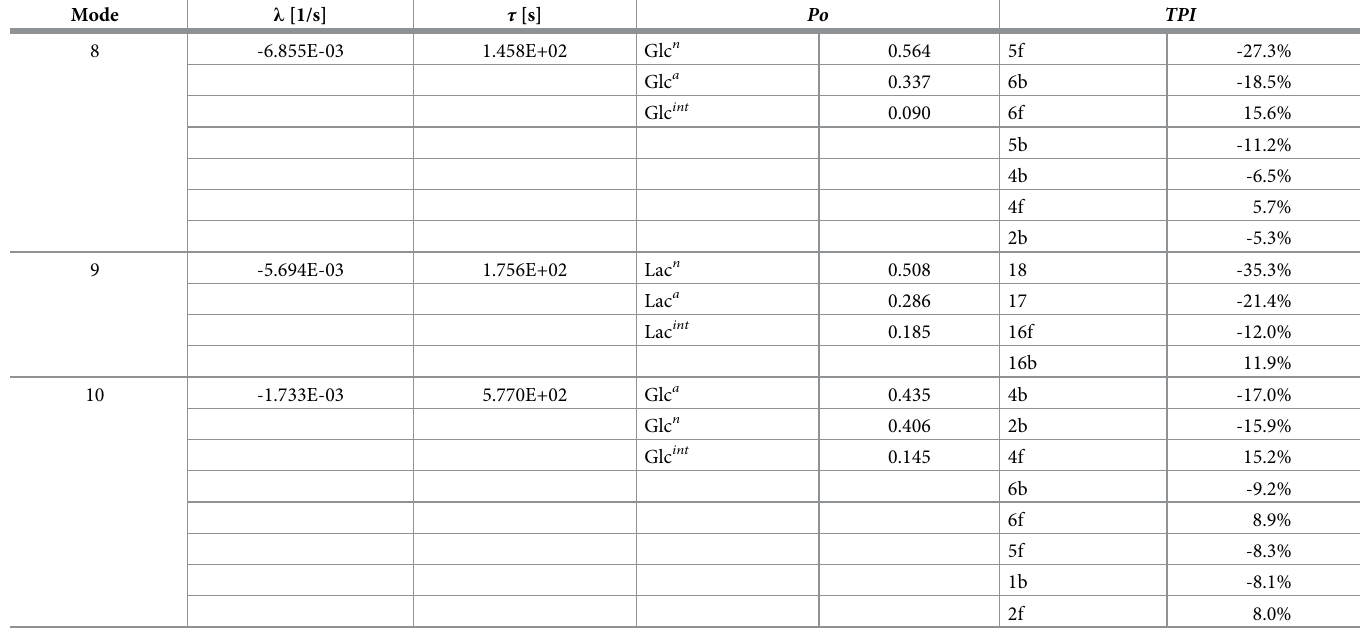
Table 4. CSP diagnostic tools for the 3 active modes in the NALS case.